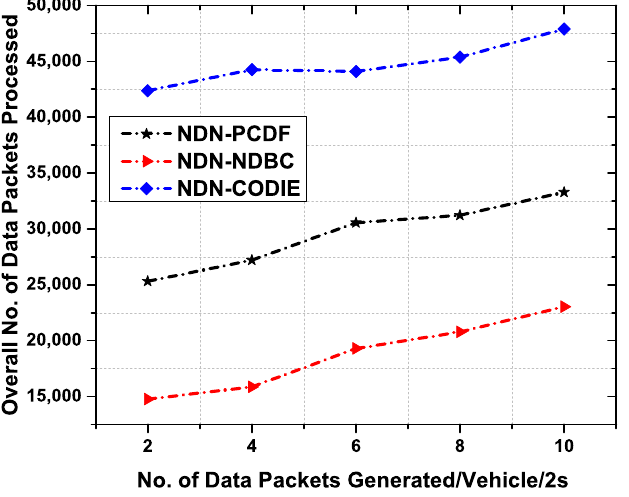
Figure 12. Overall number of data packets processed as a function of number of data packets generated per 2